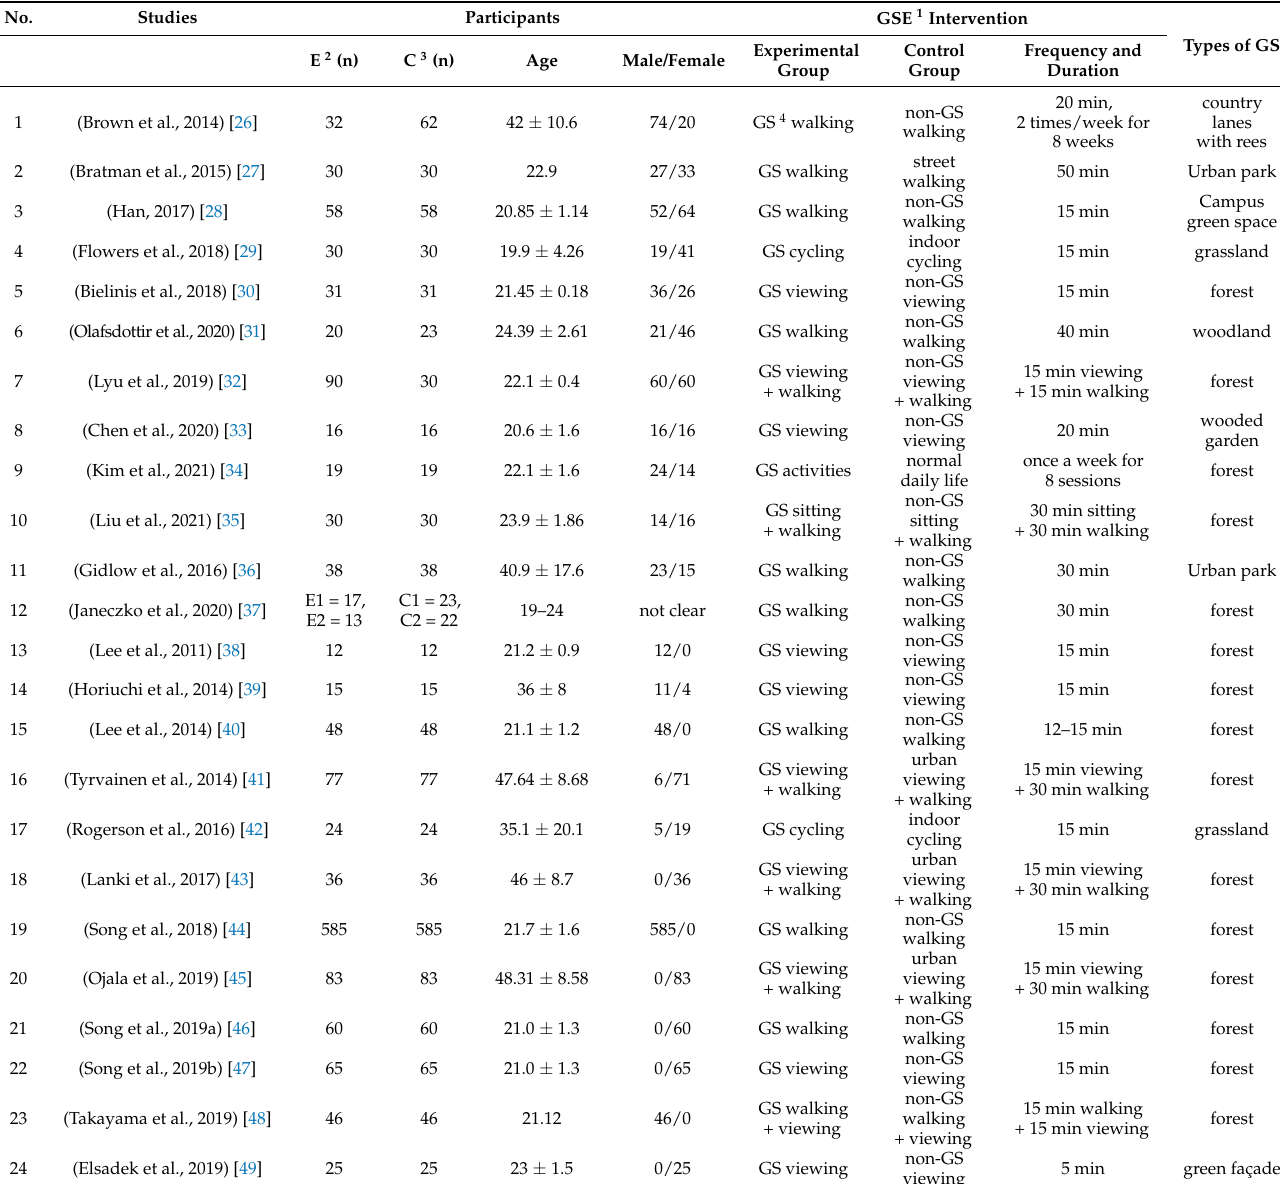
Table 1. Characteristics of Studies Included in